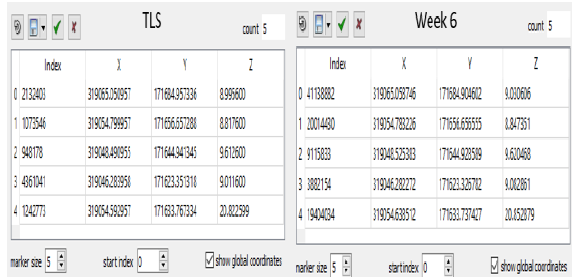
Figure 17. Pole Survey (on white) Superimposed on an